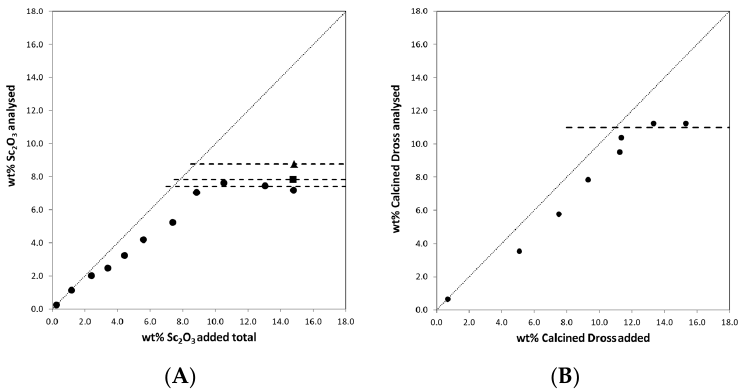
Figure 2. ( A ) Oxide solubility determinations in cryolite melt, CR = 2.2. Oxide source added as Sc 2 O 3 . The operating temperature, ( • ) 980 ◦ C, was increased at the end to investigate the effect of the temperature at saturation point, i.e., ( (cid:4) ) 1000 ◦ C and ( (cid:78) ) 1020 ◦ C. ( B ) Oxide solubility determinations in cryolite melt, CR = 2.2. Oxide source added as dross after calcination of the fine fraction. T = 980 ◦